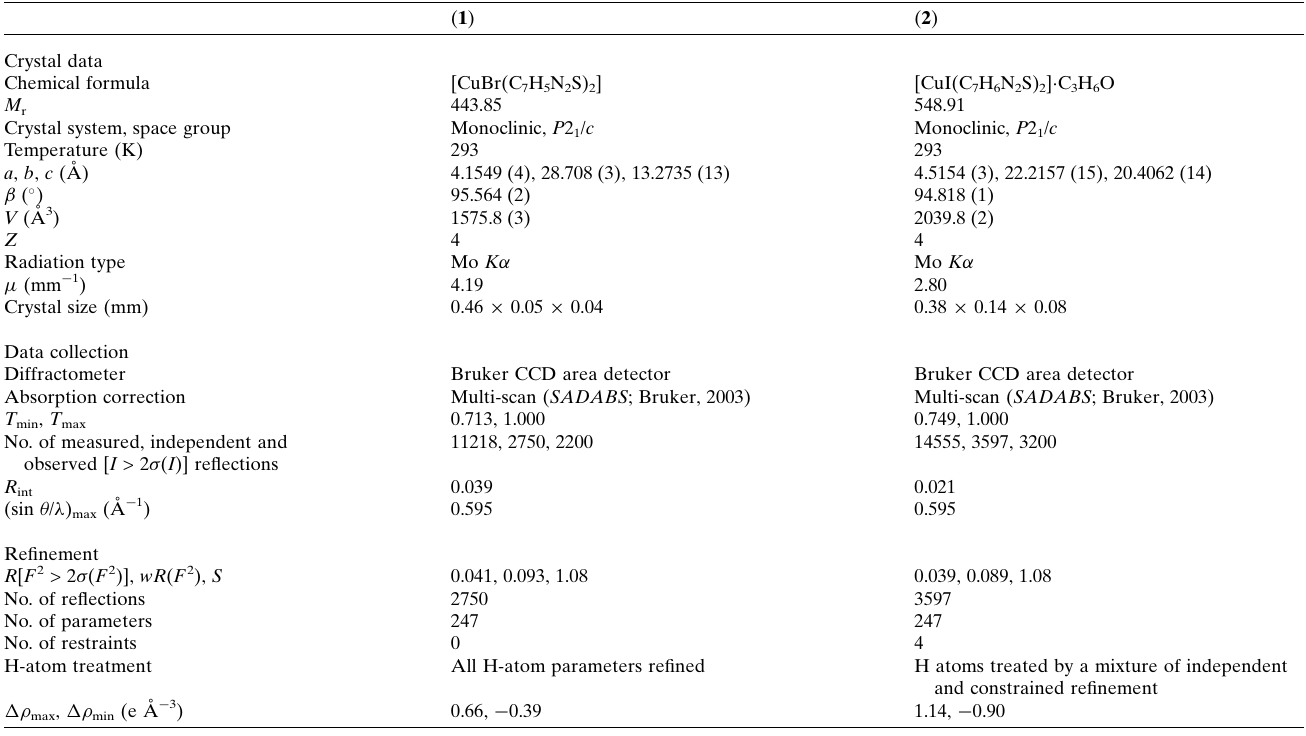
Table 6 Experimental